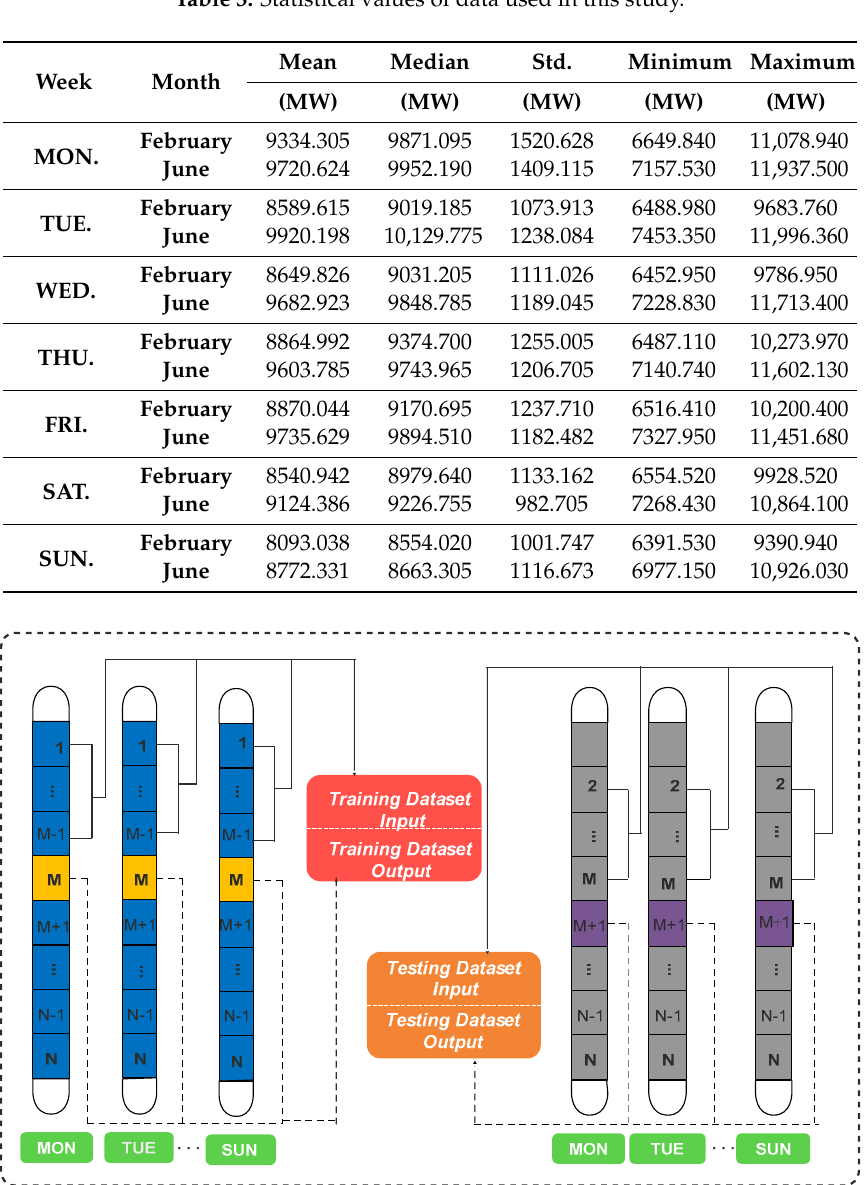
Figure 3. Process of longitudinal data selection.